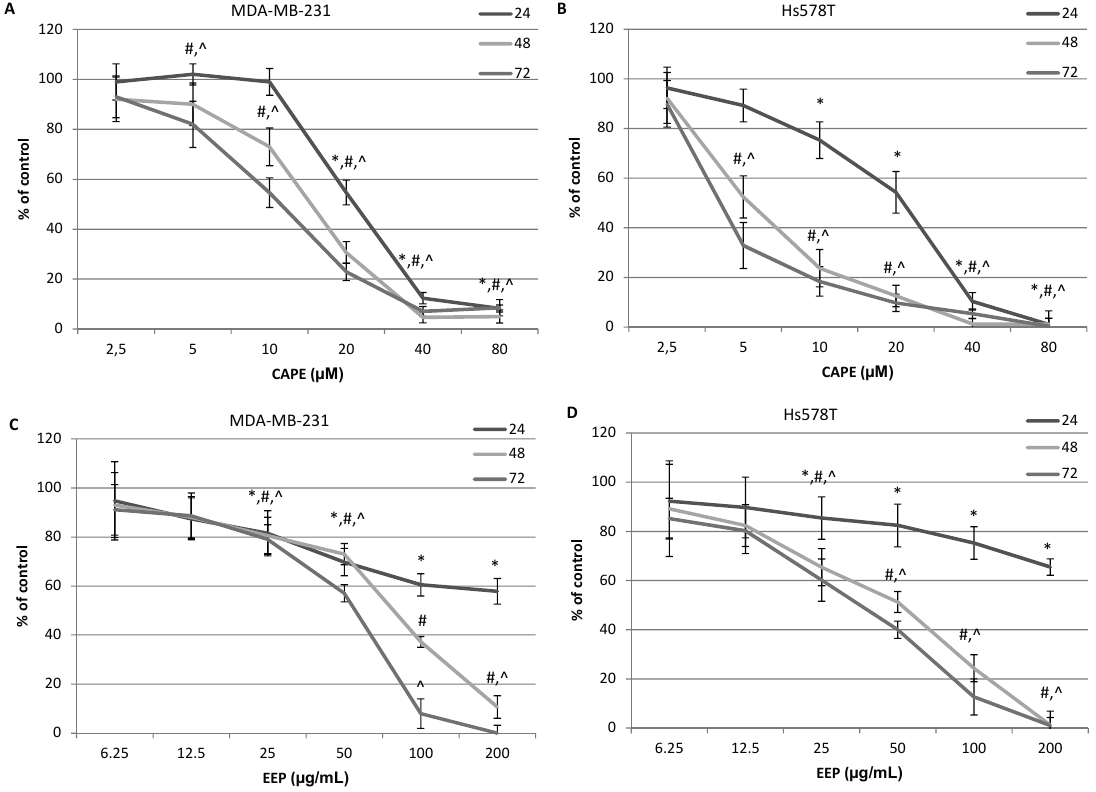
Figure 2. Cytotoxic effects of EEP and CAPE on MDA-MB-231 and Hs578T breast cancer cells. Cells were incubated with 6.25–200.0 μ g·mL − 1 EEP or with 2.5–80.0 μ